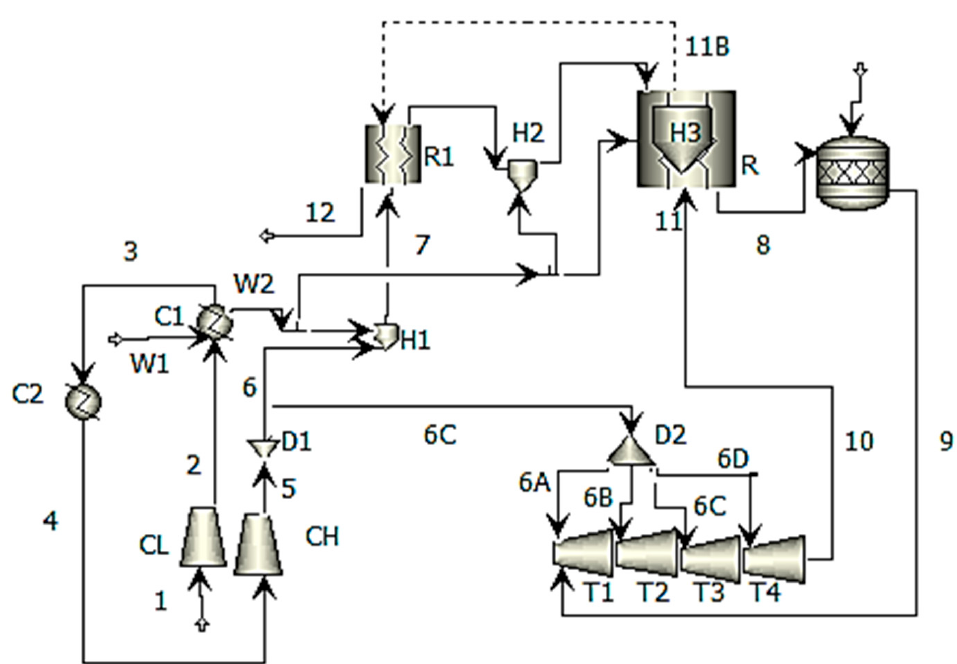
Figure 8. Scheme of the humid-air heat-and-power plant.